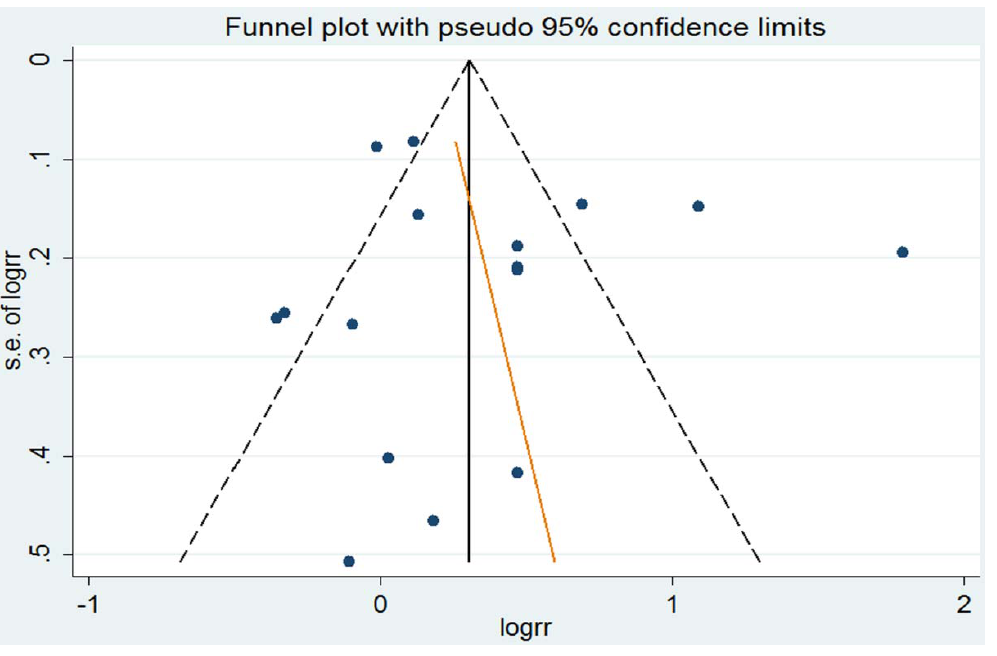
Figure 6. The funnel plot of milk consumption and the risk of NHL. Each dot represents a different study.